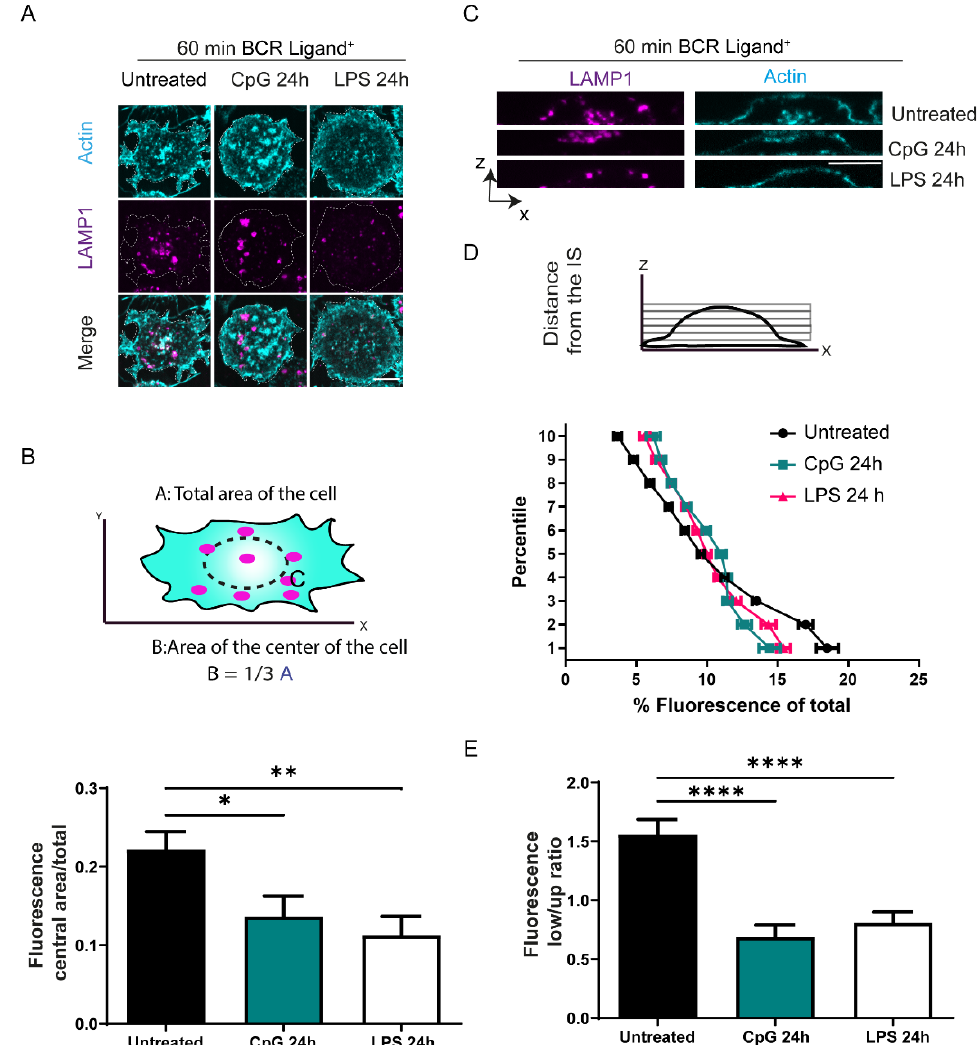
Figure 2. Lysosome distribution at the IS of B cells pre-treated with CpG or LPS. ( A ) Representative confocal images of control, LPS, and CpG pre-treated B cells activated on antigen-coated coverslips for 60 min stained for Lysosomes, LAMP1 (magenta) and F-actin, phalloidin (Cyan) ( B ) Scheme depicting central and total areas defined in the B cell synapse. Graphs represent the ratio between central and total area. * p < 0.05, ** p < 0.01, N = 3 (>35 cells). One-way ANOVA with Dunnet’s multiple comparison test. ( C ) representative X/Z confocal images from control, CpG, and LPS pre-treated B cells activated on antigen-coated coverslips for 60 min, stained for Lysosomes, LAMP1 (magenta) and F-actin, phalloidin (Cyan). ( D ) Quantification of the LAMP1 fluorescence along the Z dimension from the coverslip to the upper cell limit of control, CpG and LPS pre-treated cells. N = 3 (>38 cells). ( E ) Graphs represent the ratio between the bottom half of the cell and the upper half of the cell from cells shown in C. **** p < 0.0001 N = 3 (>38 cells). One-way ANOVA with Dunnet’s multiple comparison test.